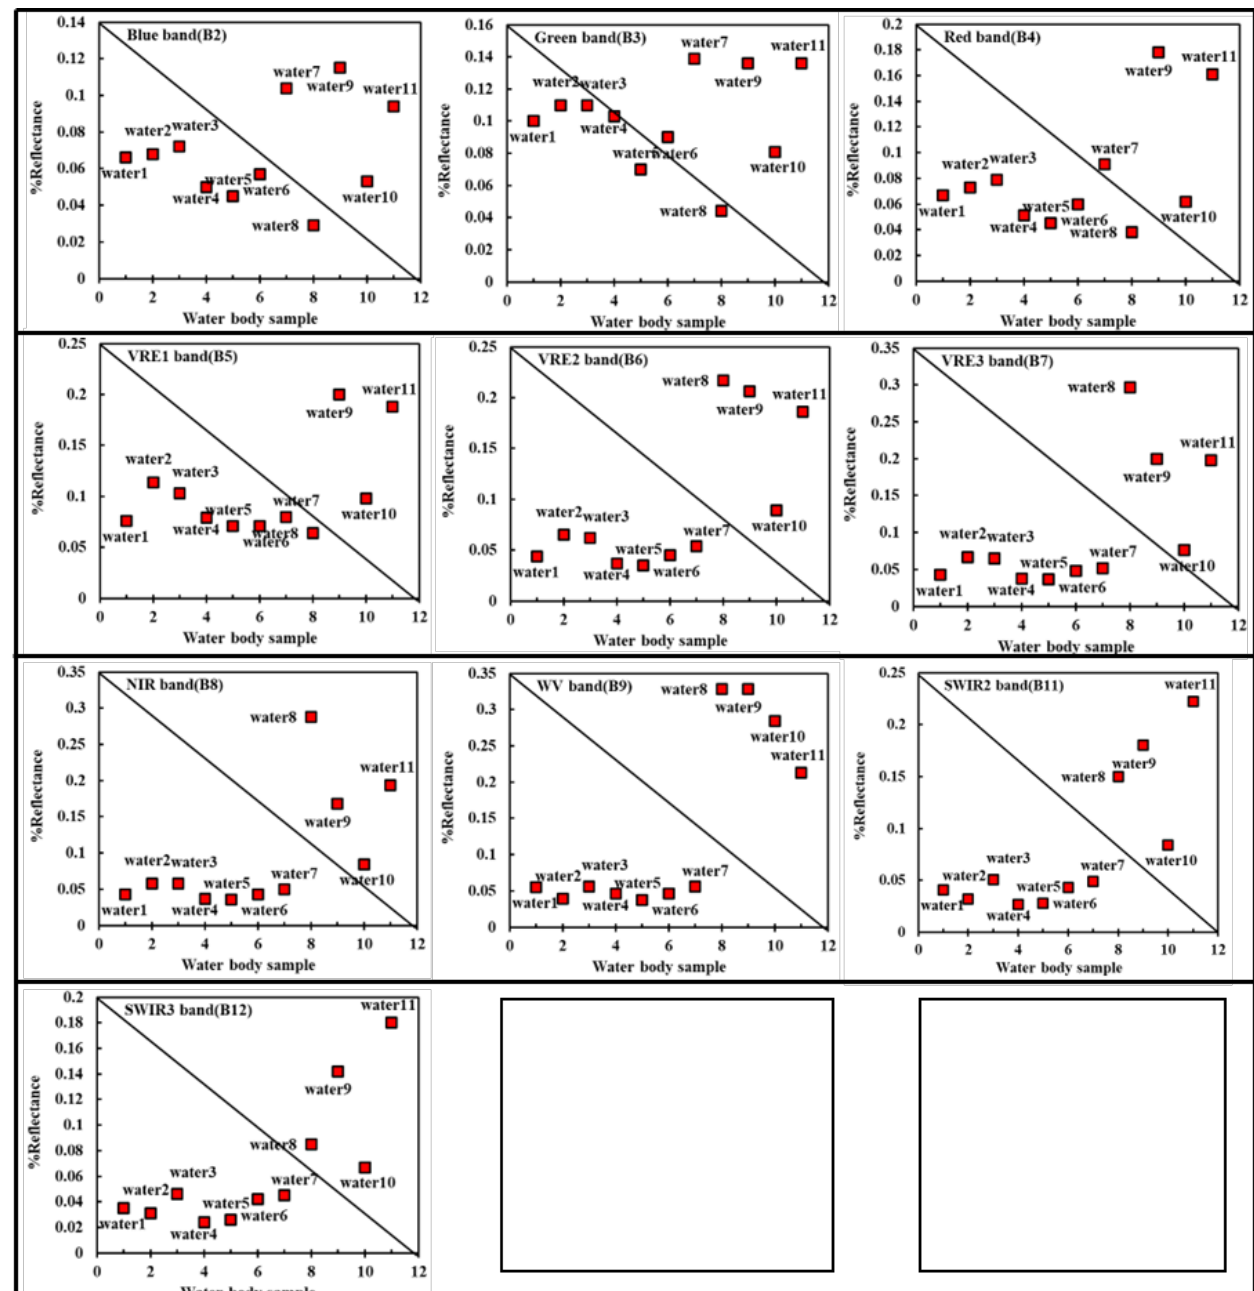
Figure 3. Distribution of reflectance values per water sample for all Sentinel-2 bands used. The line drawn from the point of origin at the bottom right of the rectangular coordinate system to the top left separates two clusters of waterbodies with different features, as described above.